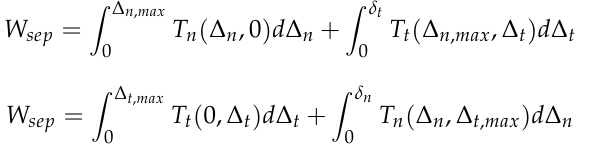
Figure 6. The work-of-separation 𝑊 𝑠𝑒𝑝 ( a , b ); work conducted by the normal traction 𝑊 𝑛 ( c , d ); and work conducted by the tangential traction 𝑊 𝑡 ( e , f ); with respect to the change of the proportional angle 𝜃 . Park–Paulino–Roesler (PPR) model ( a,c,e ); simplified PPR traction–separation law (SPPR) model ( b,d,f ).